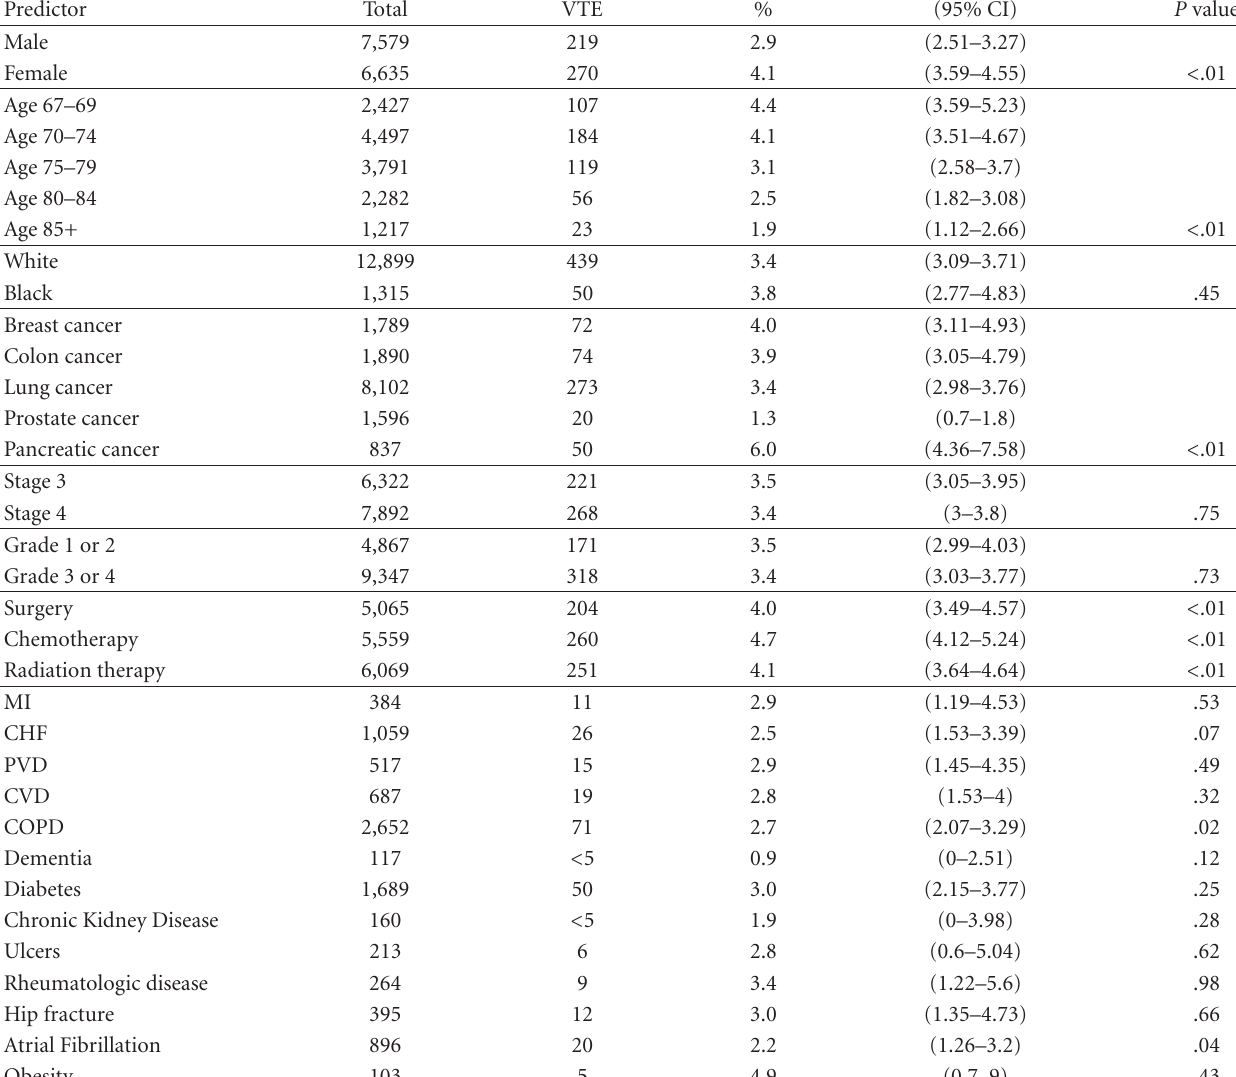
Bivariate analysis of cancer and patient characteristics on development of VTE. The following comorbid conditions were removed because of prevalences < 100: paralysis, cirrhodites, AIDS, and central venous catheter. Myocardial infarction: MI; congestive heart failure: CHF; peripheral vascular disease: PVD; cerebrovascular disease: CVD; chronic obstructive pulmonary disease: